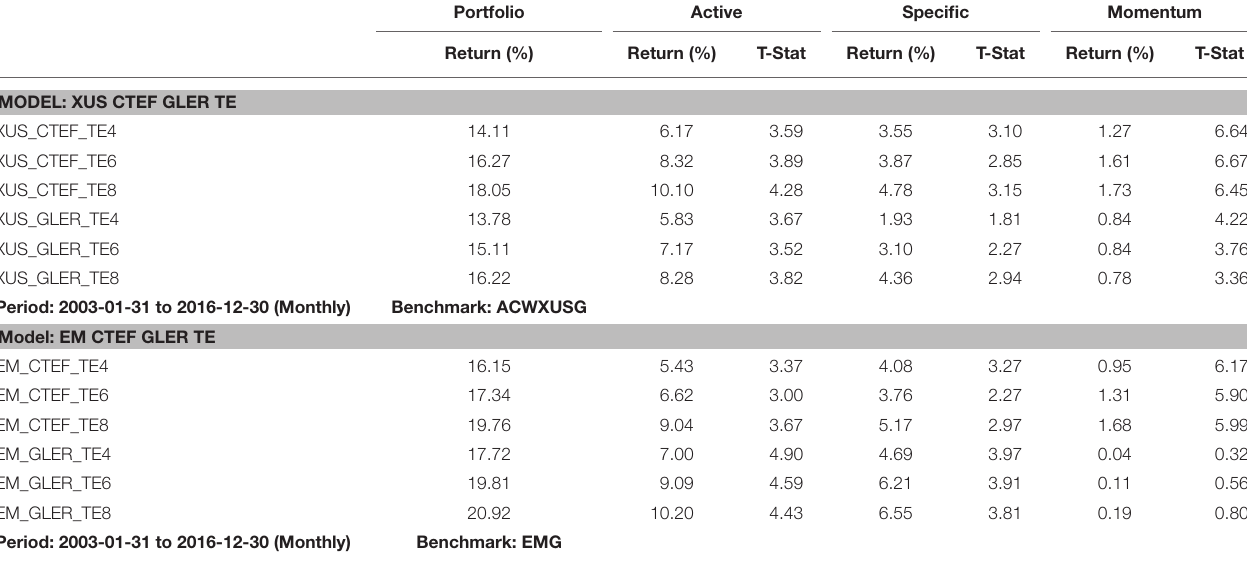
TABLE 1 | Forecasted earnings acceleration and stock selection modeling in global, Non-US, and EM universes using MSCI Index Constituents-only. Portfolio Active Specific Momentum Return (%) Return (%) T-Stat Return (%) T-Stat Return (%) T-Stat